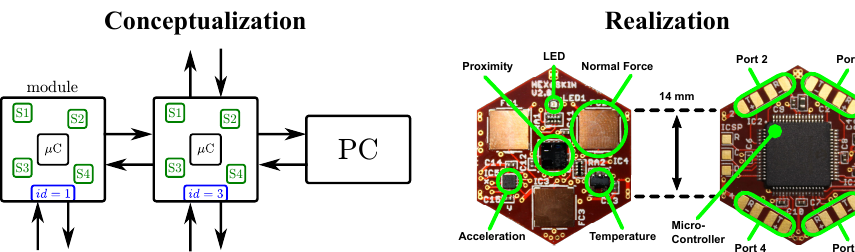
Figure 1. Conceptualization: Each sensor module/skin cell employs different sensors (e.g., S1, . . . , S4) and a microcontroller ( µ C) for local processing capabilities; the modules are inter-connected, form a network of modules, and provide a bidirectional communication path between each module and information handling systems, for example, a computer (PC); Realization: One skin cell of our e-skin system